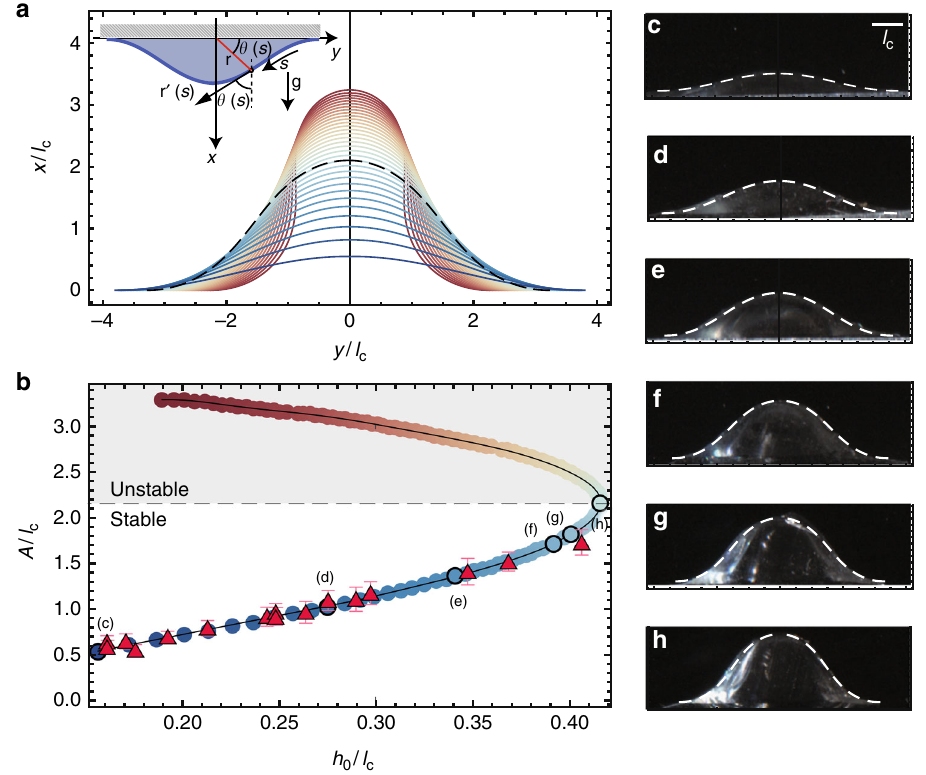
=‘ ; A =‘ and average experimental amplitudes (red 0 c c